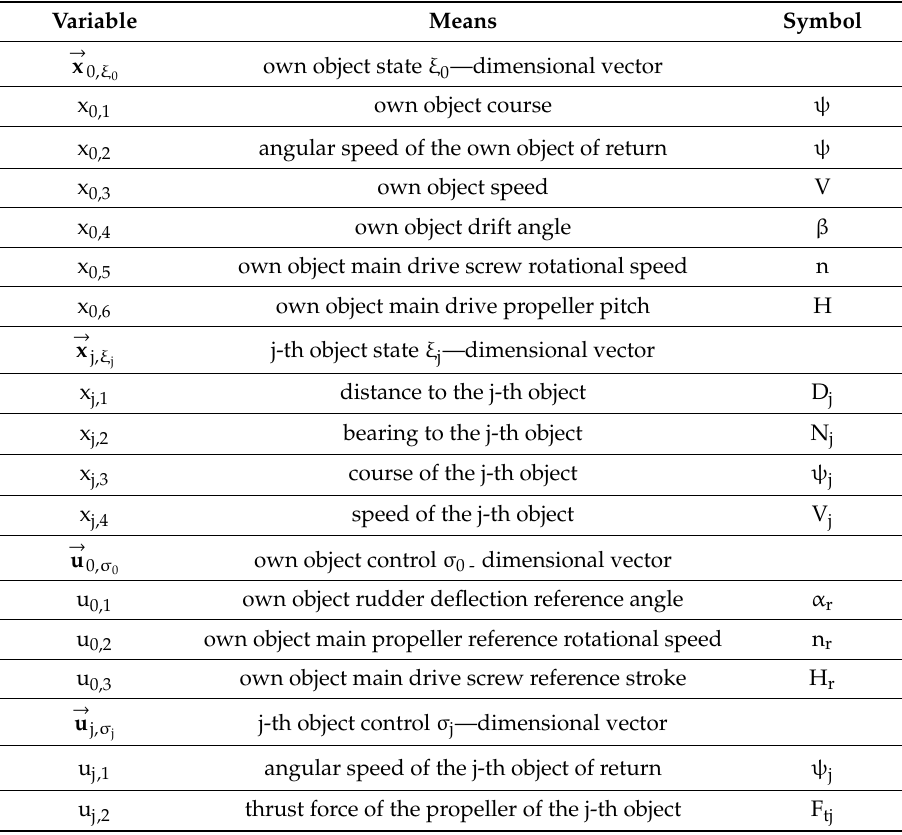
Table 1. Description of state and control